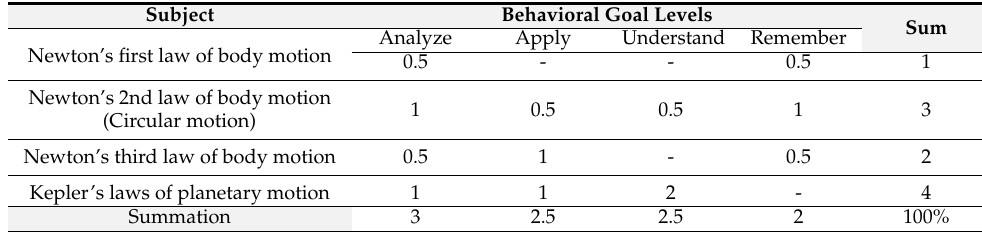
Table 2. Specifications of cognitive test for practical experience skills.